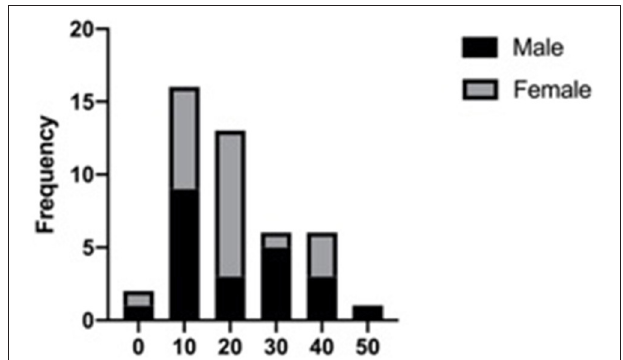
FIGURE 1 | Age and gender groups.